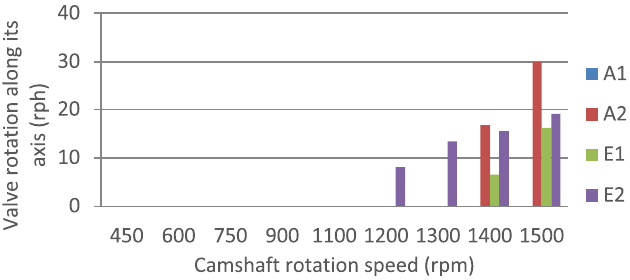
Fig. 13. Determination of valve rotation speed in function of camshaft rotation speed depending of valve position in the cylinder (A1: intake 1, E1: exhaust 1,